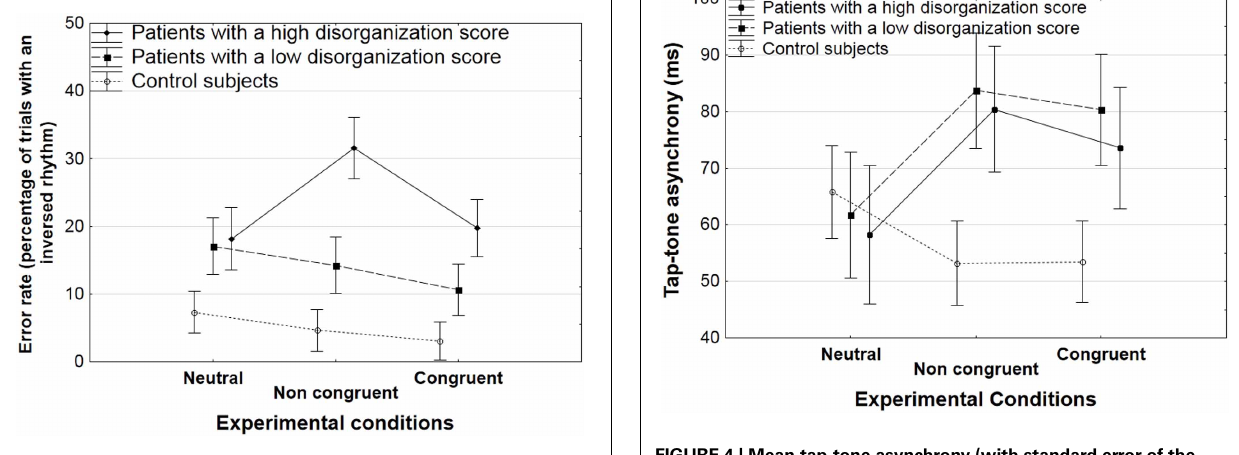
FIGURE 3 | Mean rate of errors (trials with an inverted rhythm) with standard errors of the means (SEM) as a function of the experimental condition (neutral, non-congruent, congruent) in patients with a high and low disorganization score, and in controls.